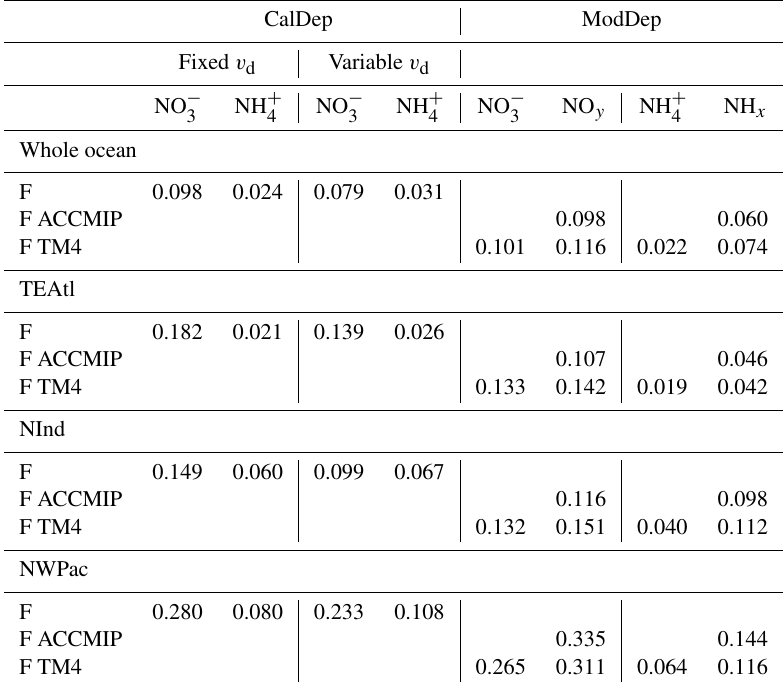
Table 2. Summary of areal average CalDep and ModDep fluxes (F,mg Nm − 2 d − 1 ) of NO − observations for the whole ocean and the TEAtl, NInd and NWPac